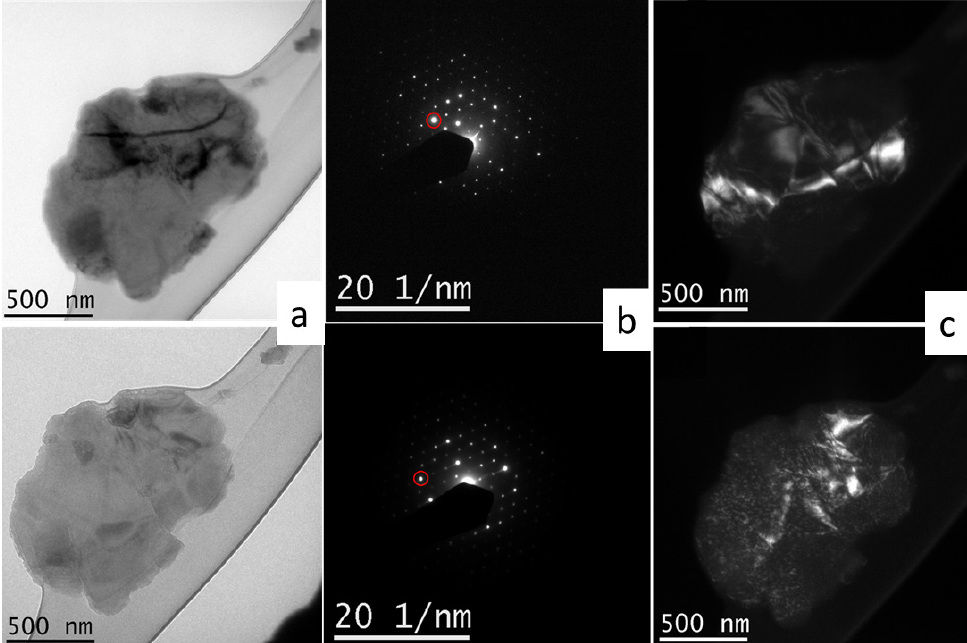
Figure 10. Two TEM bright/dark-field images of a co-formed and coalesced ternary nanoparticle aggregate: 10Cu–80Ni–10Co (reduction at 600 ◦ C/10 min) obtained at a slightly different incident beam/sample orientation ( a ), the corresponding diffraction pattern ( b ) marking the operating reflec- tion for the dark field images ( c ) revealing different portions of the nanocrystalline aggregate.